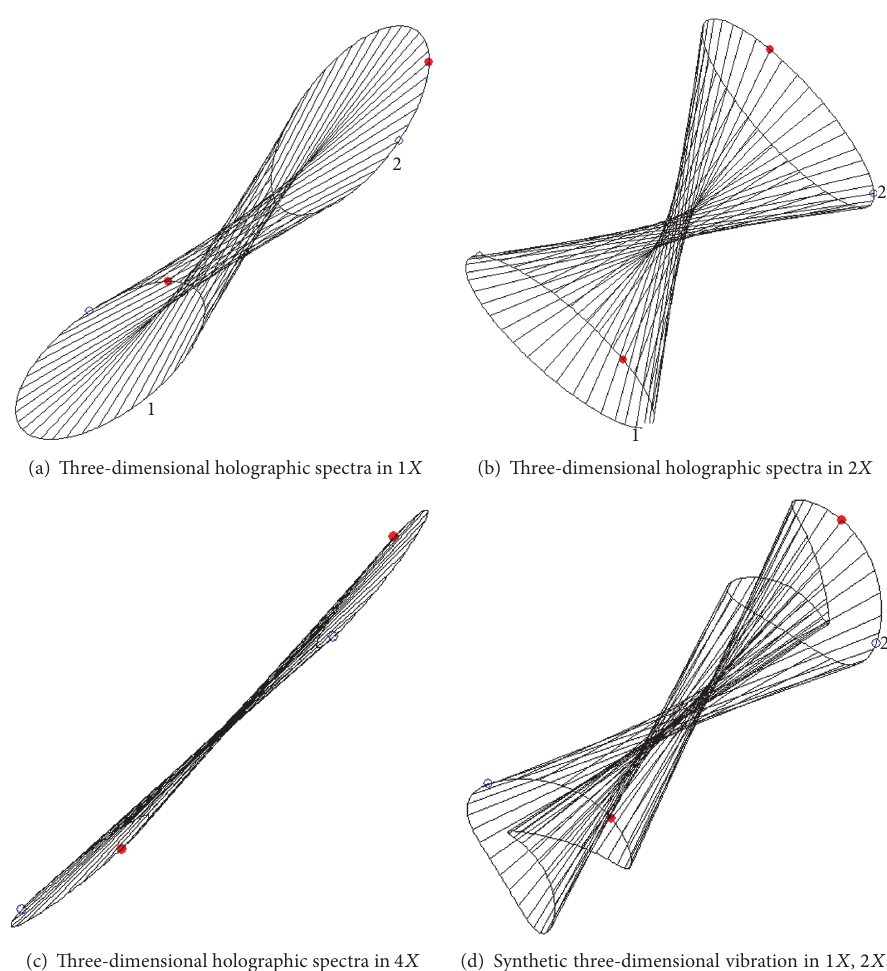
Figure 9: Three-dimensional vibration components.